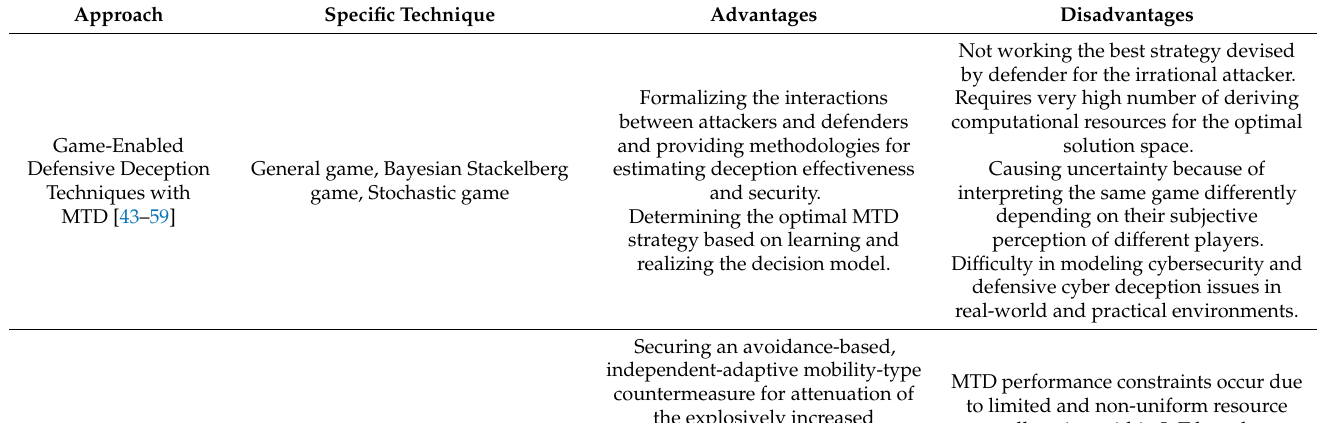
Table 1. Taxonomy of existing defensive deception research studies and proposed deceptive model for